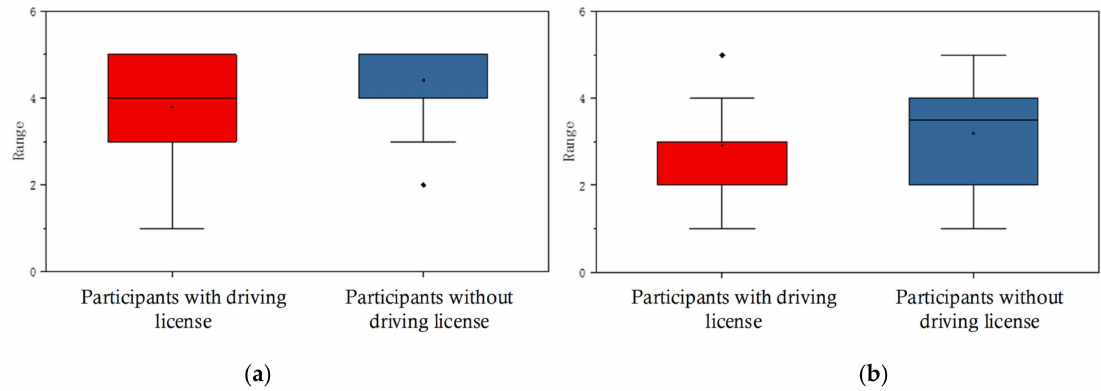
Figure 4. The rank distribution of eHMIs: ( a ) Textual eHMI; ( b ) Textual and Symbolic eHMI in With/Without driver’s license groups, presented through